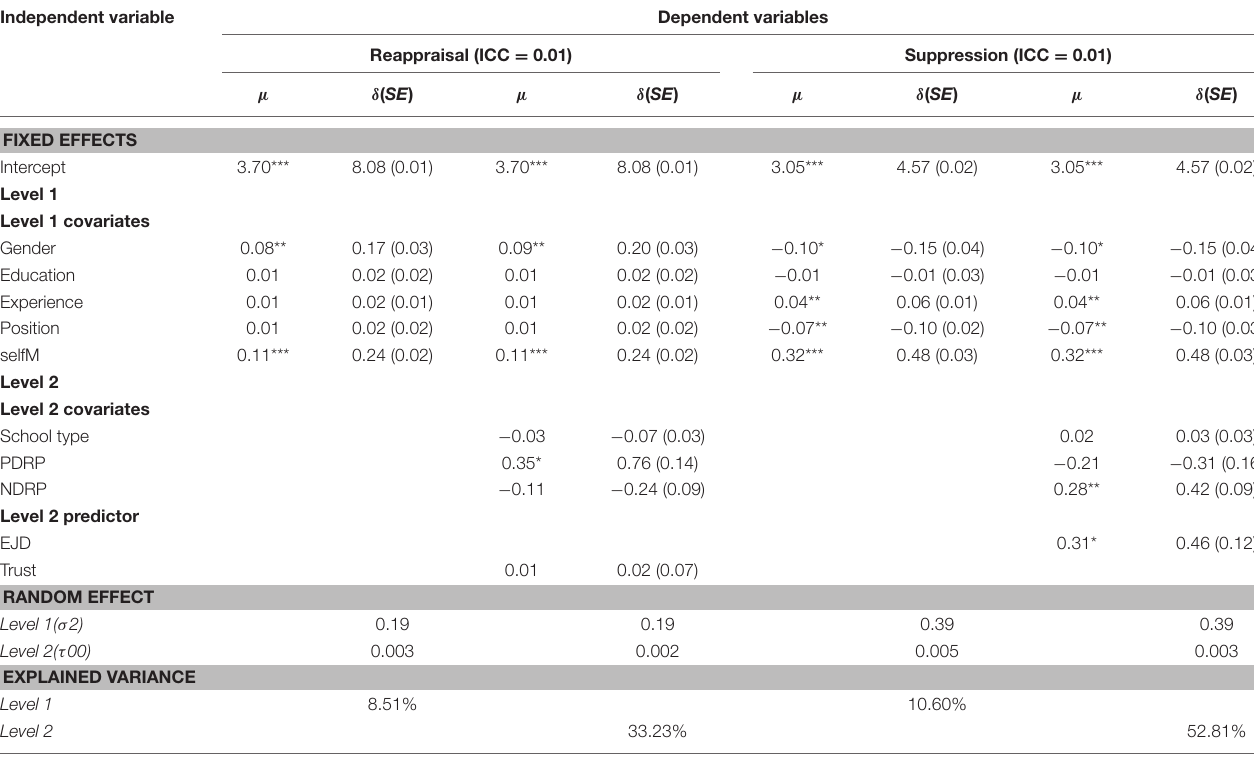
TABLE 4 | Multilevel estimates for models predicting reappraisal and suppression. Independent